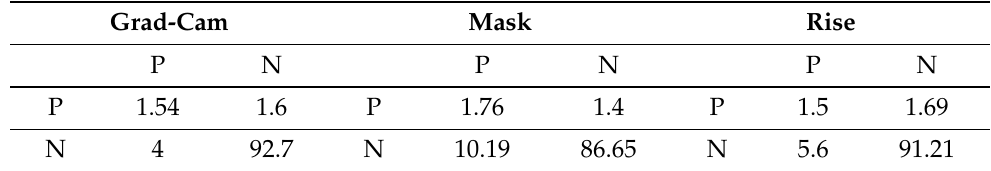
Table 2. Confusion matrix of different interpretation algorithms (P means Positive, N means Negative).